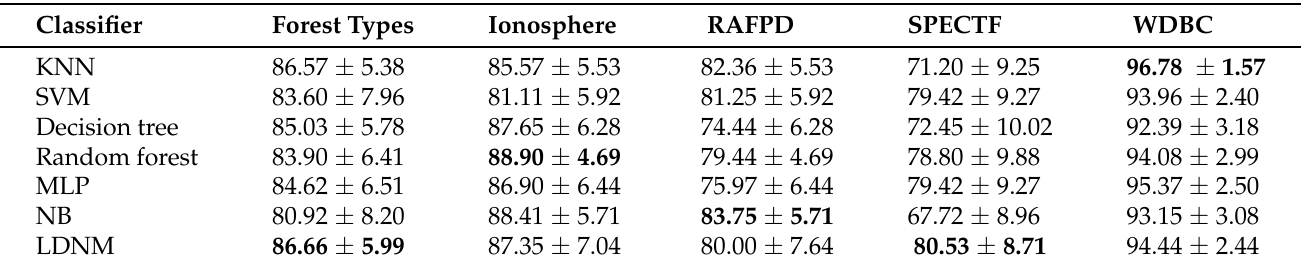
Table 6. The comparisons of the classification accuracy among different classifiers for five problems.